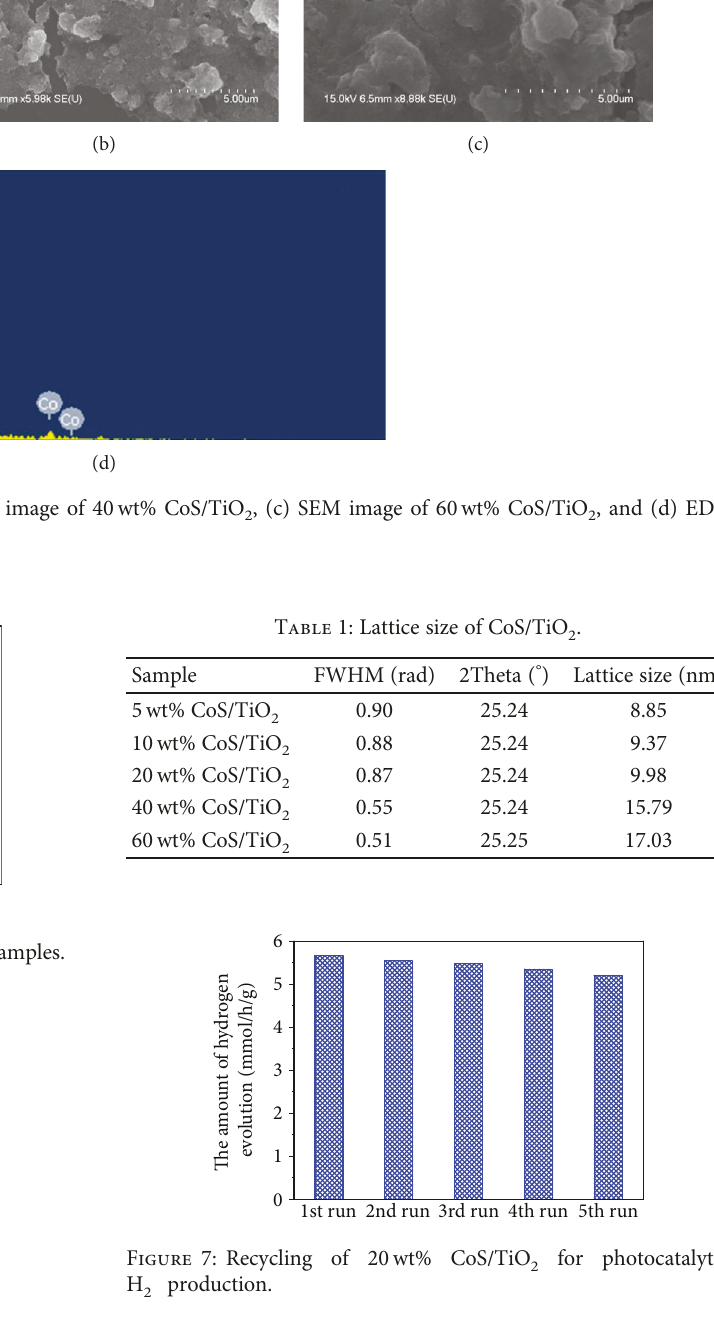
Figure 6: Photocatalytic H